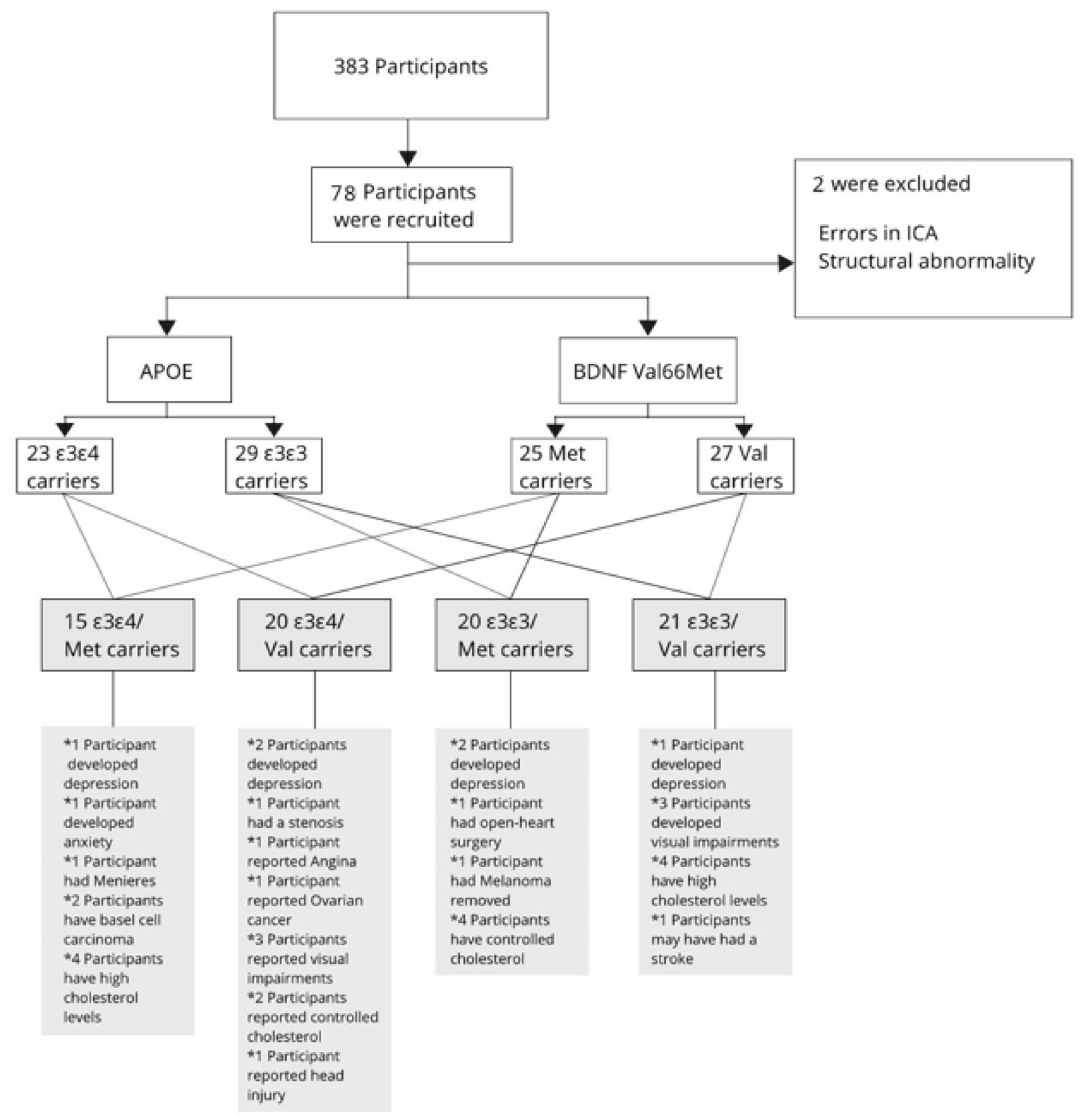
Figure 4. Tasmanian Healthy Brain Project participants, recruitment, inclusion, exclusion, genotypes, and developed medical